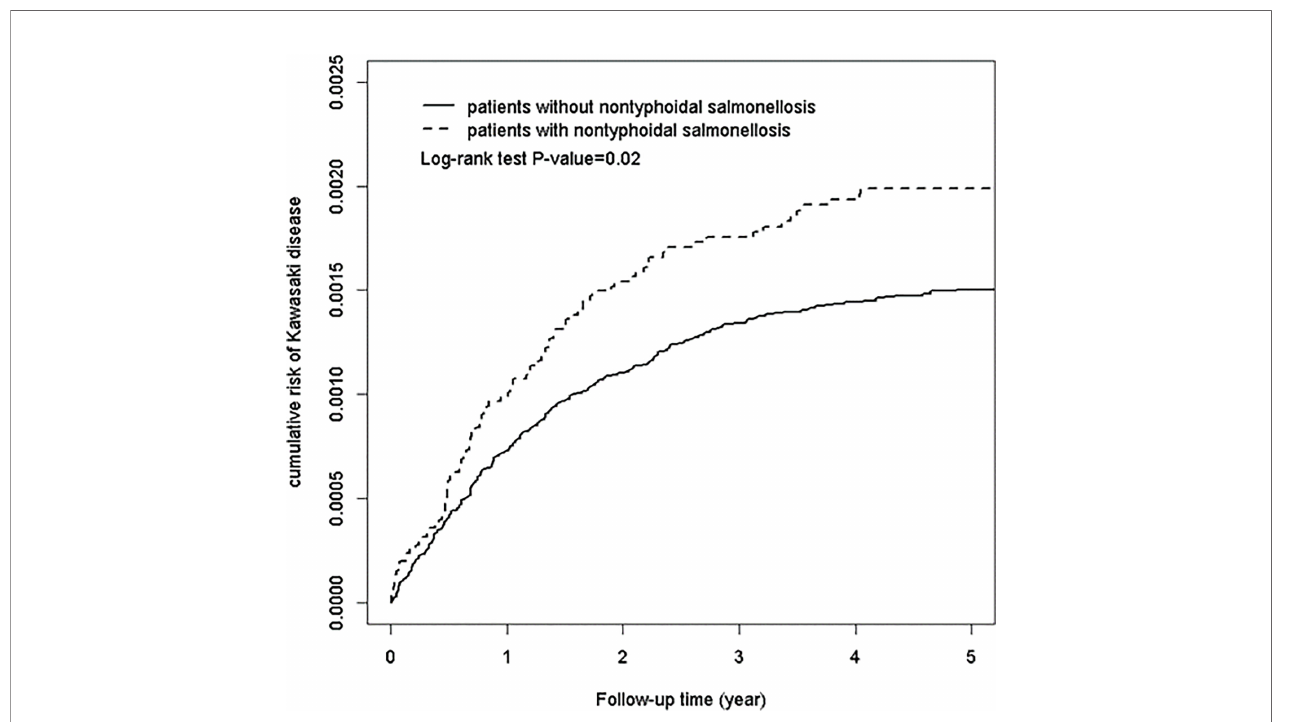
FIGURE 1 | Cumulative risk of Kawasaki disease in patients with and without non-typhoidal Salmonella